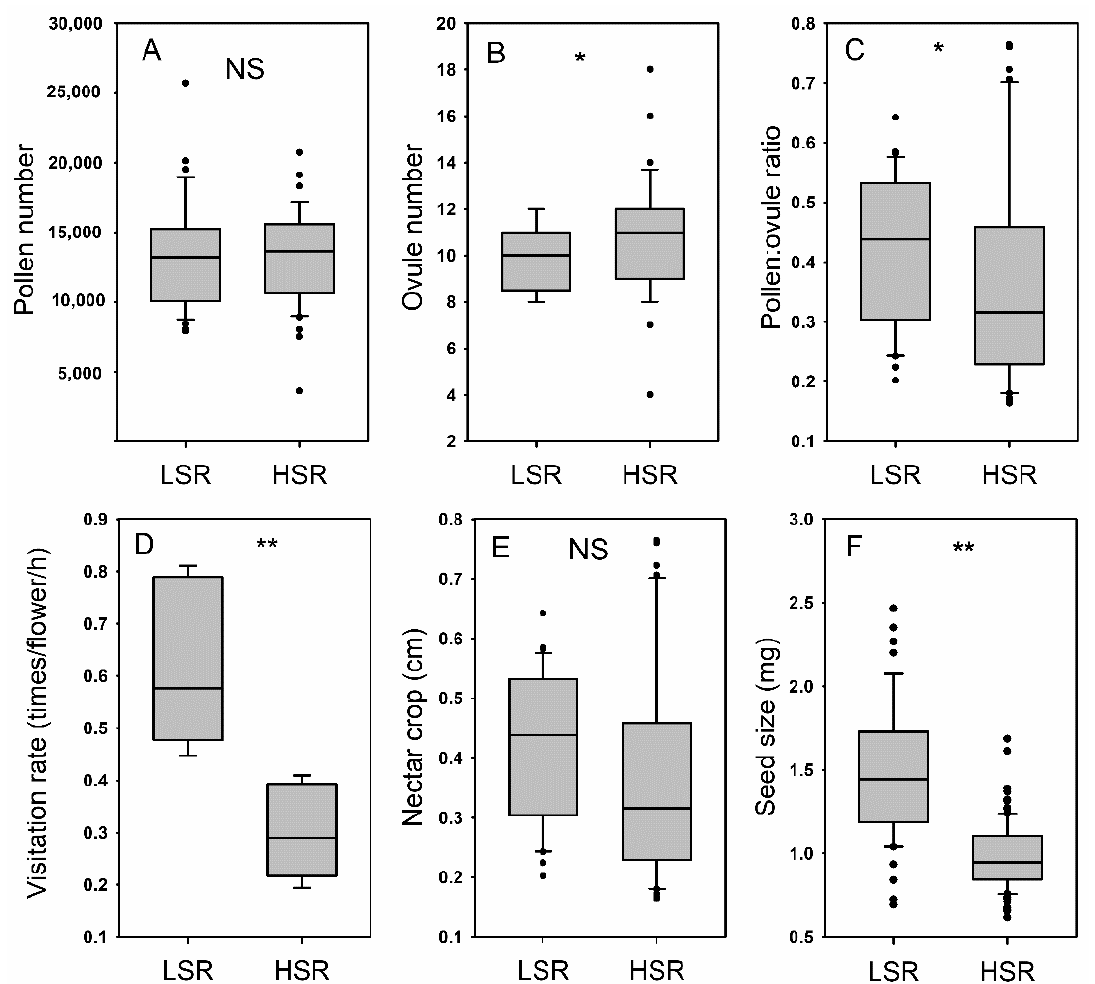
Figure 1. Pollen number ( A ), ovule number ( B ), pollen–ovule ratio ( C ), pollinator visitation rate ( D ), nectar crop ( E ), and seed size ( F ) of Halenia elliptica in a population with a low selfing rate (LSR) and a high selfing rate (HSR). Seed production comparisons are shown in Table 1. **, p < 0.01; *, p < 0.05; NS, p > 0.05.